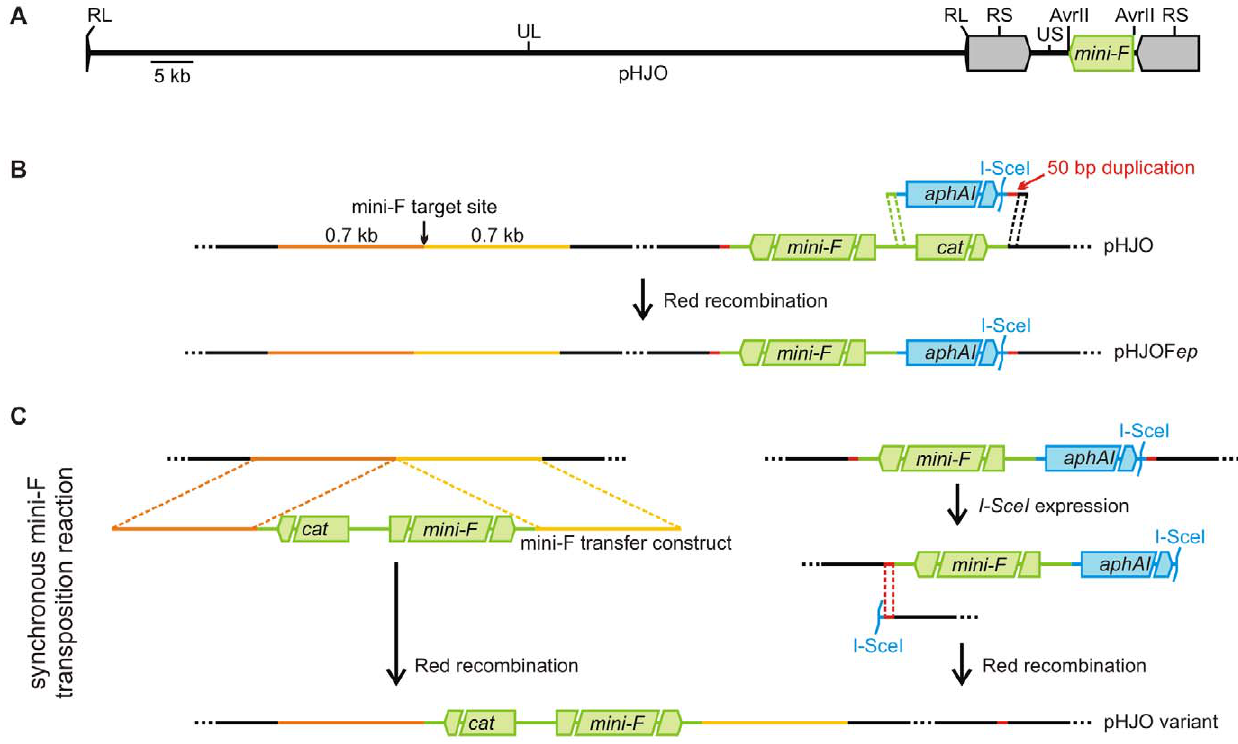
Figure 1. Mini-F vector transposition. A ) The infectious BAC pHJO. In the pHJO BAC clone the mini-F sequences are located within the unique AvrII site of the VZV US region. RL: repeat of the long region; UL: unique region long; RS: repeat of the short region; US: unique region short. B ) Preparation of the BAC for the mini-F transposition. An aphAI -I-SceI cassette (blue) was amplified with primers bearing specific 50 bp extensions (green and black). One primer provides a 50 bp duplication (red). The generated PCR product was applied to replace the cat gene of the pBeloBAC11 vector sequences (green) from pHJO, resulting in pHJOF ep . C ) Synchronous mini-F transposition reaction. A mini-F transfer construct was used to insert a second pBeloBAC11 vector via Red-mediated recombination of flanking 0.7 kb homologous sequences (orange and yellow) into the target position of interest. After introduction of a double-strand break by I-SceI expression, the primary mini-F cassette was seamlessly excised by a second Red-mediated recombination of the short 50 bp duplication, resulting in a pHJO